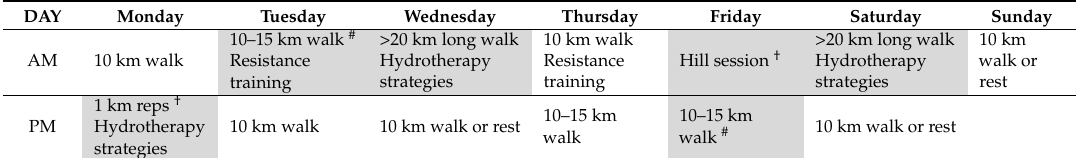
Table 2. Template for weekly training program. Shading indicates mandatory sessions; remaining sessions could be modified by individual